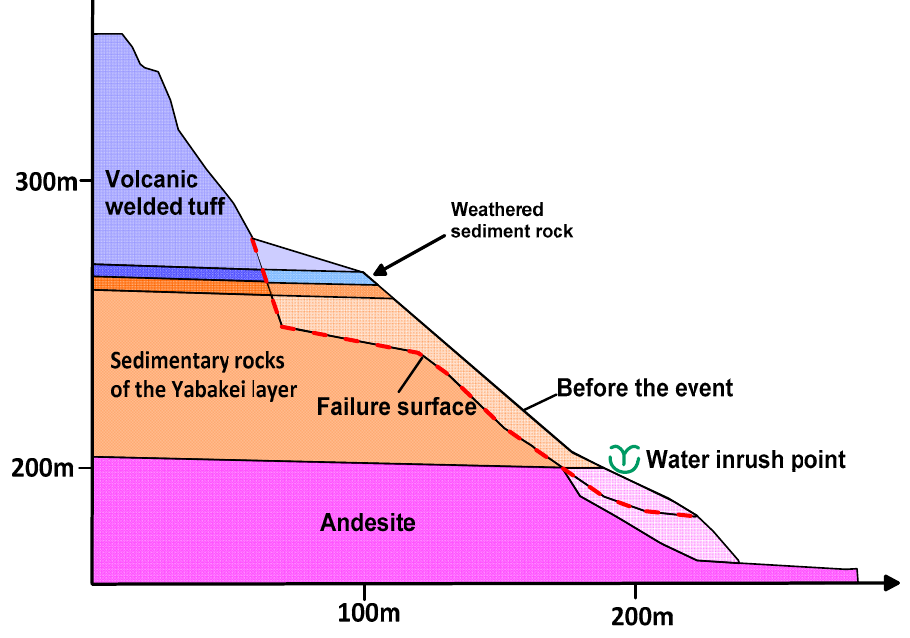
Figure 6. The longitudinal geological section of the Yabakei landslide.